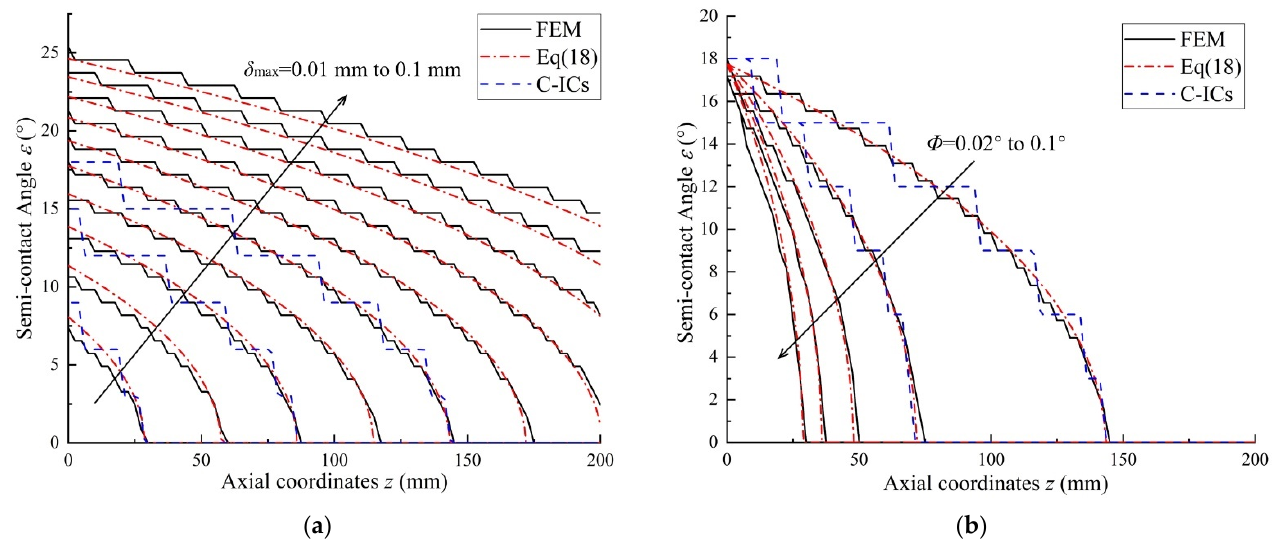
Figure 12. Comparison of contact area: ( a ) The approachment δ max changed from 0.01 mm to 0.1 mm; ( b ) the inclination Φ changed from 0.02 ◦ to 0.1 ◦